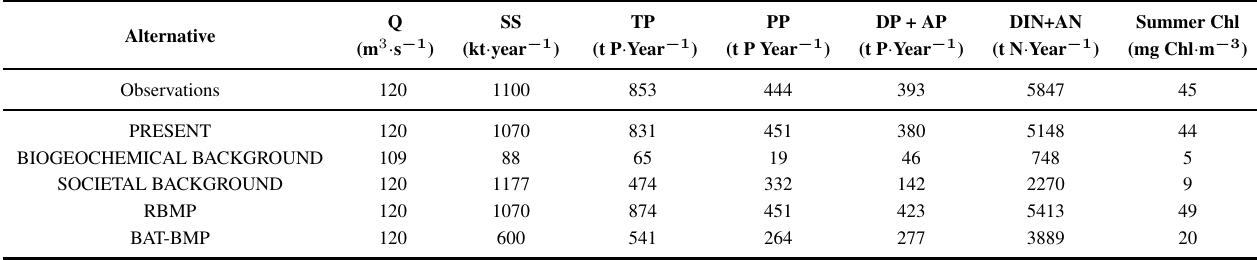
Table 2. Annual mean nutrient fluxes and summer mean algal biomass (Chl) at Csenger according to observations and in different